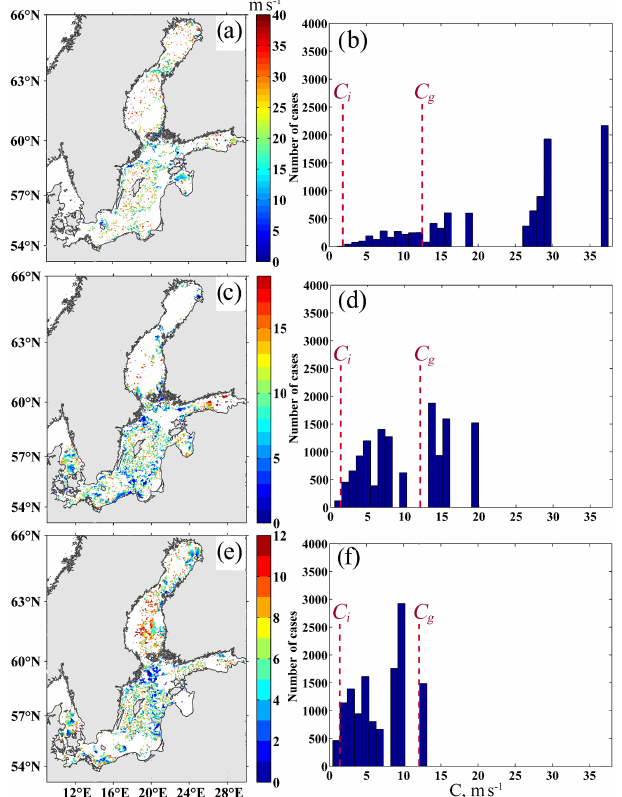
Figure 13. Maps and histograms of phase speed of progressive– standing waves of 13h (a, b) , 27h (c, d) , and 41h (e, f) periods in the baroclinic sea. In the regions coloured in white, the estimated phase speed is equal to zero. The dashed line on the histogram plots indicates maximal theoretical value of phase speed of baroclinic gravity waves ( C i ) and minimal theoretical value of phase speed of barotropic ( C g ) gravity waves.